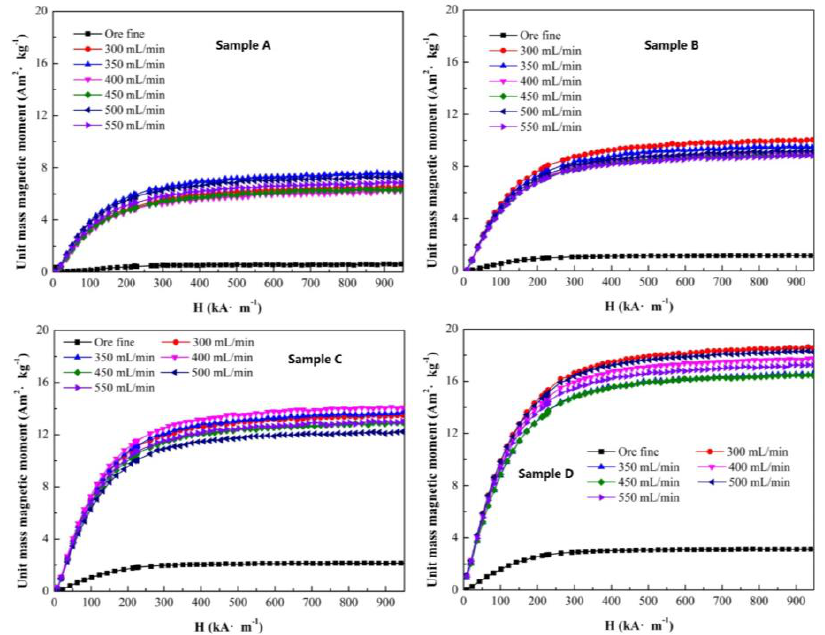
Figure 11. The unit mass magnetic moment of sample A to D with different gas flows.